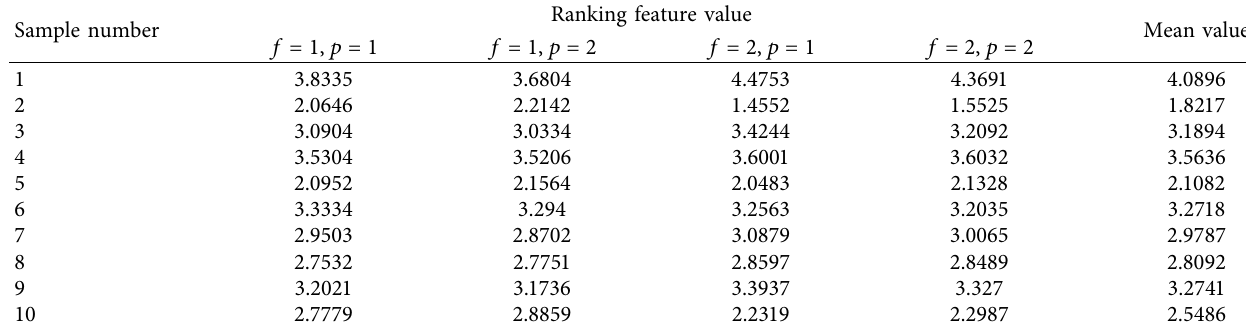
Table 9: Values of the assessment model at 10